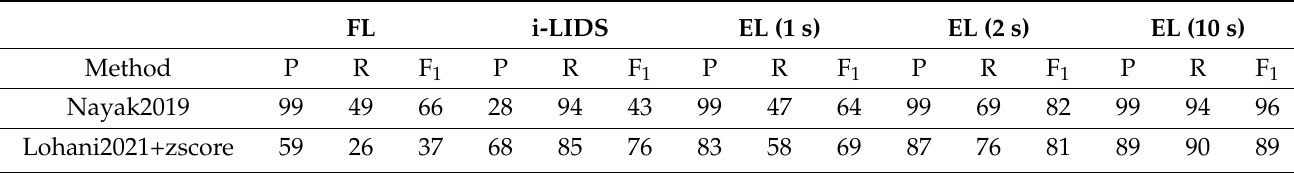
Table A2. Results as percentage on view 2 of i-LIDS test